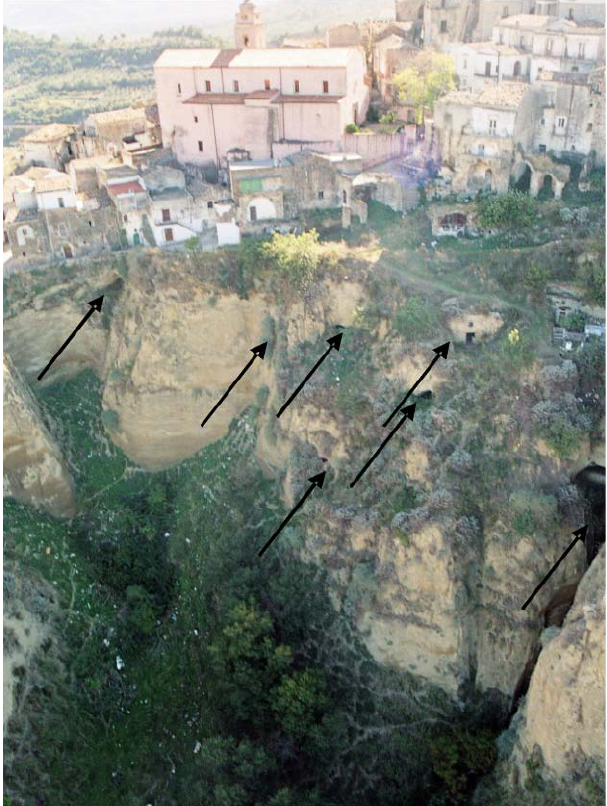
Fig. 4. Western sector of Rabatana characterized by large voids and caves (black arrows show the entries) located under the urban